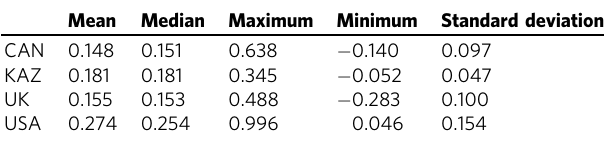
Table 9 Summary statistics for dynamic conditional correlations of wheat price returns.